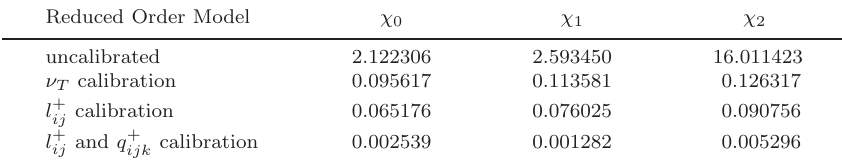
Table 4. Two-equation ROM prediction